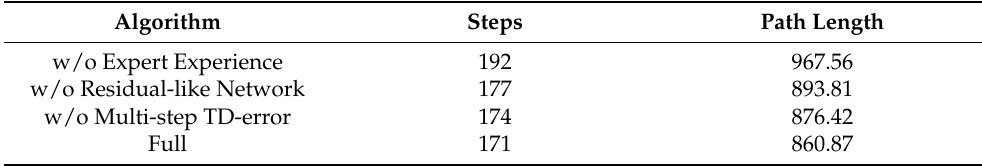
Table 7. The steps and path length in the ablation experiment.